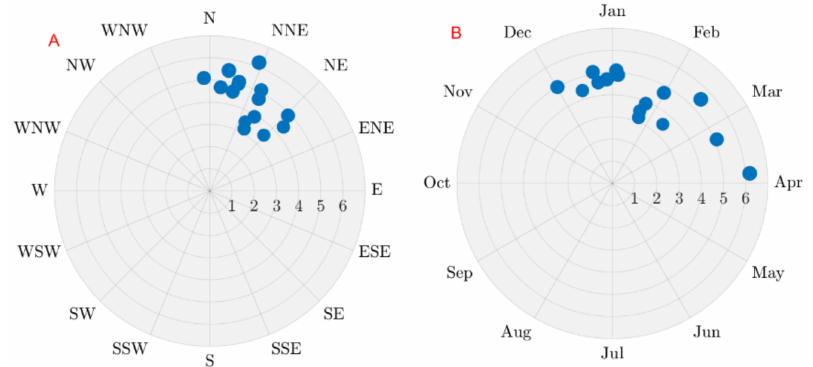
Figure 3. Annual maximum wave storms, directionality ( A ) and timing during the year ( B ) at the Ortona buoy (1999–2006). For the location of the Ortona buoy, see Figure